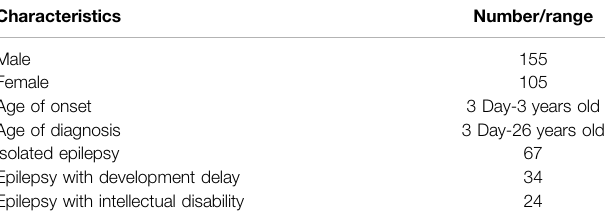
TABLE 1 | General clinical features of the probands in this study.